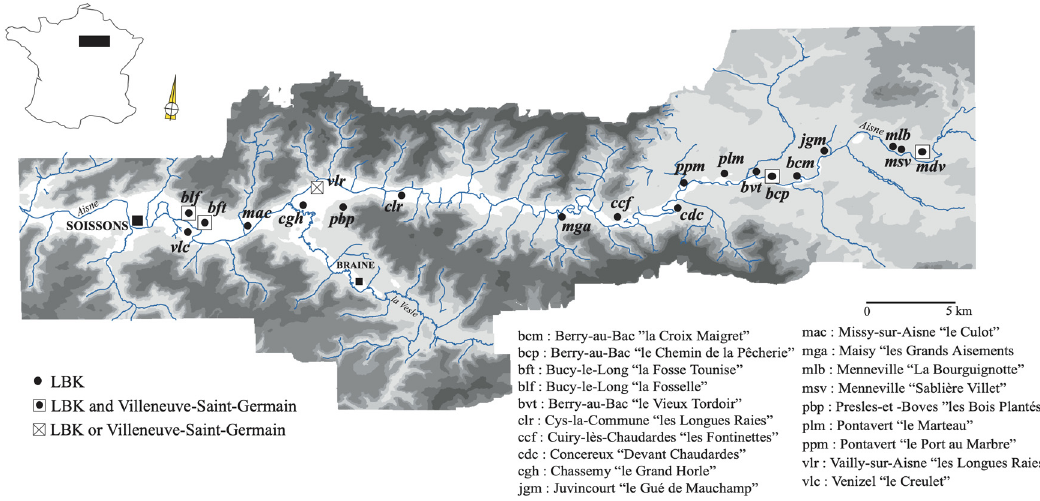
Figure 1: Distribution of Linear Pottery ( LBK ) sites in the Aisne valley study